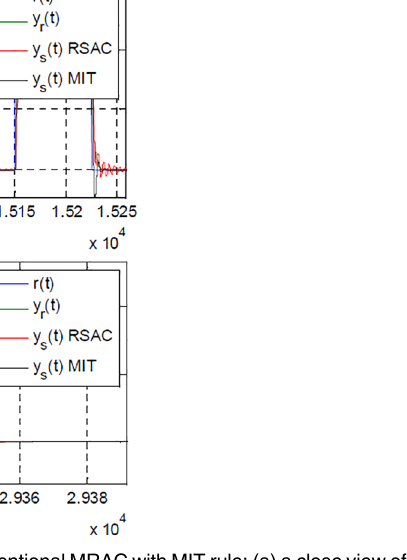
Fig 11. A comparisonof outputs of RSAC and conventional MRAC with MIT rule: (a) a close view of responses of systems for the plant perturbationat 15000 sec, (b) a close view of final responses of systems.